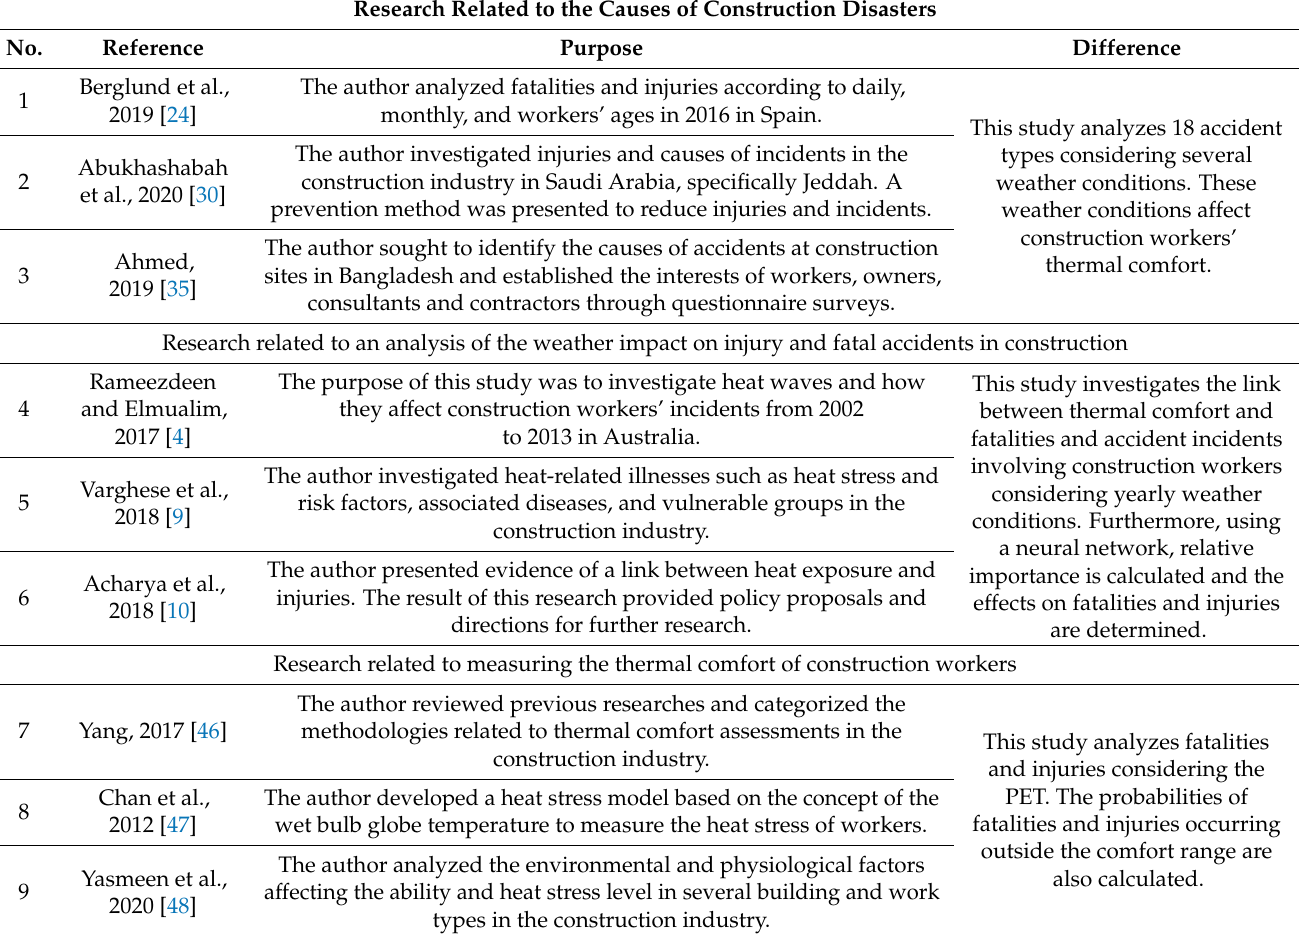
Table 1. Literature review and differences with this